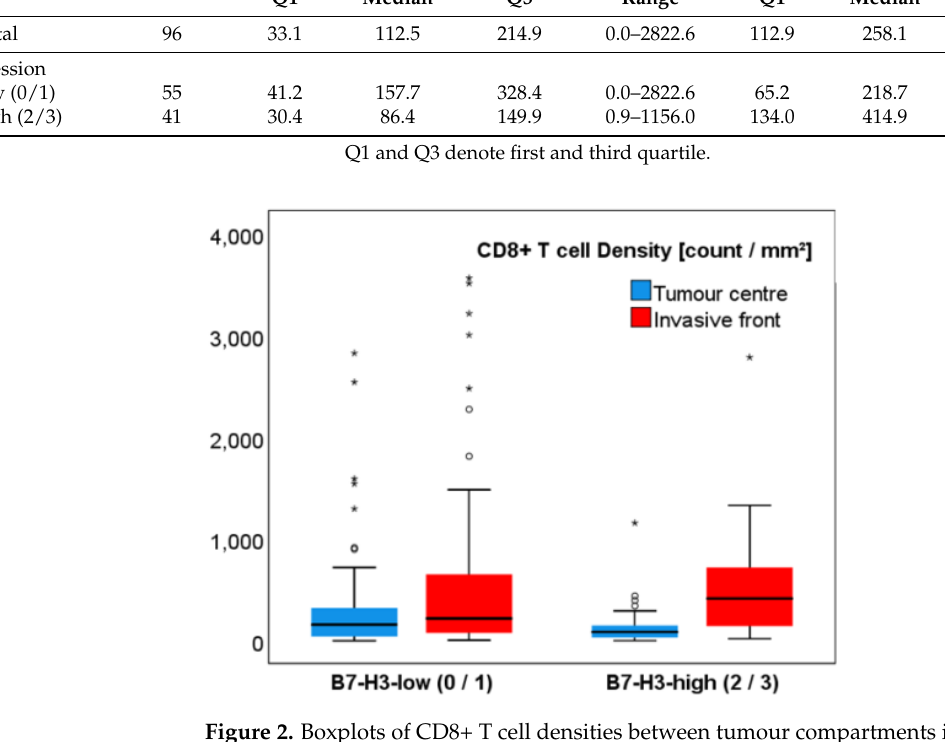
Figure 2. Boxplots of CD8+ T cell densities between tumour compartments in B7-H3-low and B7-H3- high groups. The median CD8+ T cell densities differed significantly between tumour centre and invasive front ( p < 0.001), and tumours of B7-H3-high group showed greater spatial differences of CD8+ T cells when compared to the B7-H3-low group ( p < 0.001); * extreme